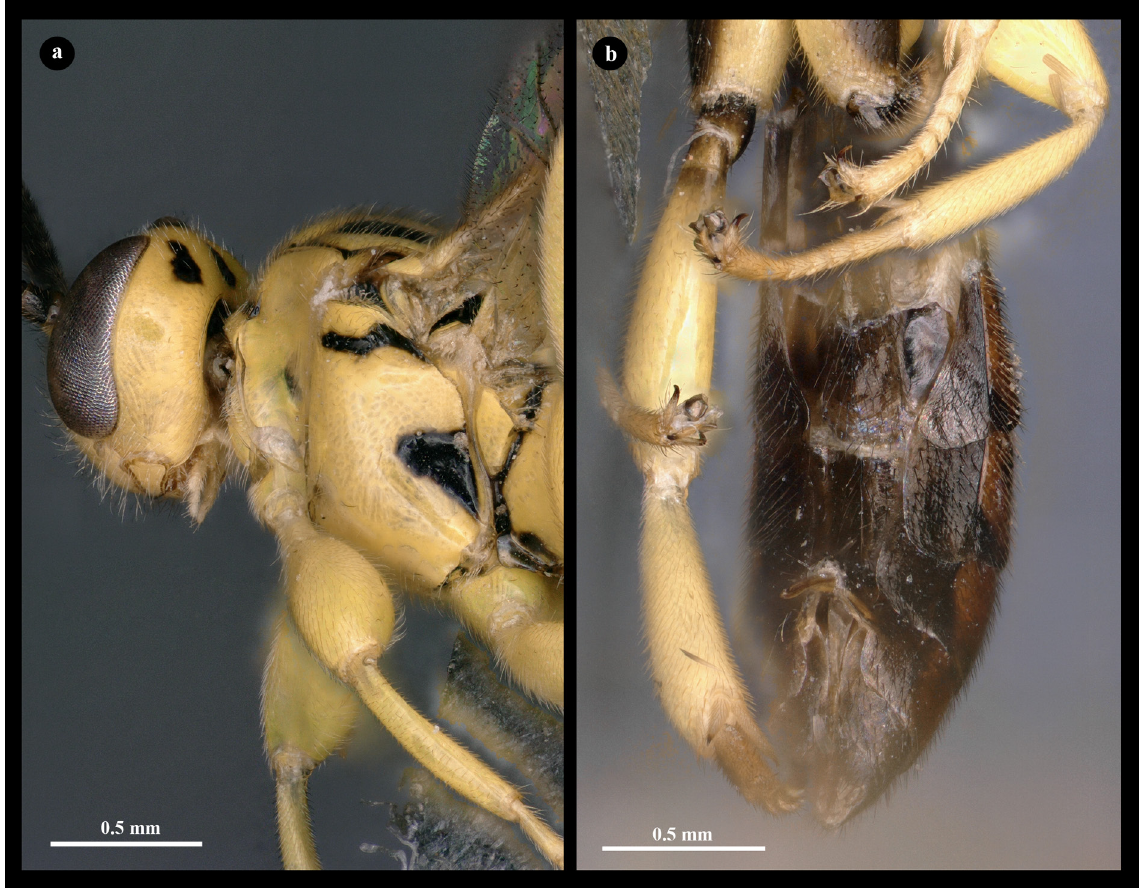
Fig. 19. Soliga ecarinata gen. et sp. nov., holotype, ♀ (AIMB). a . Head, ventro-lateral view. b . Metasoma, ventral